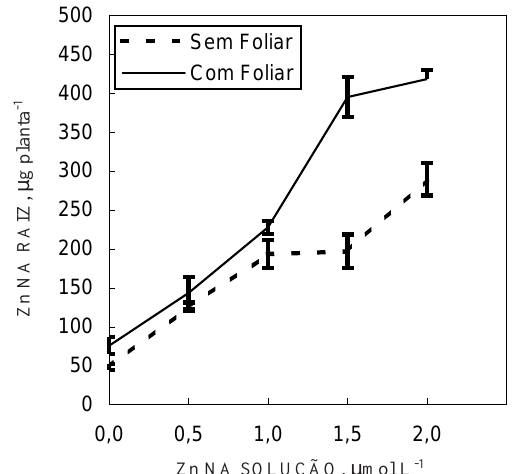
Figura 3. Conteúdo de zinco nas raízes de milho, considerando a concentração do nutriente na solução nutritiva e aplicação de zinco via foliar. As barras verticais mostram o desvio-padrão dos resultados.